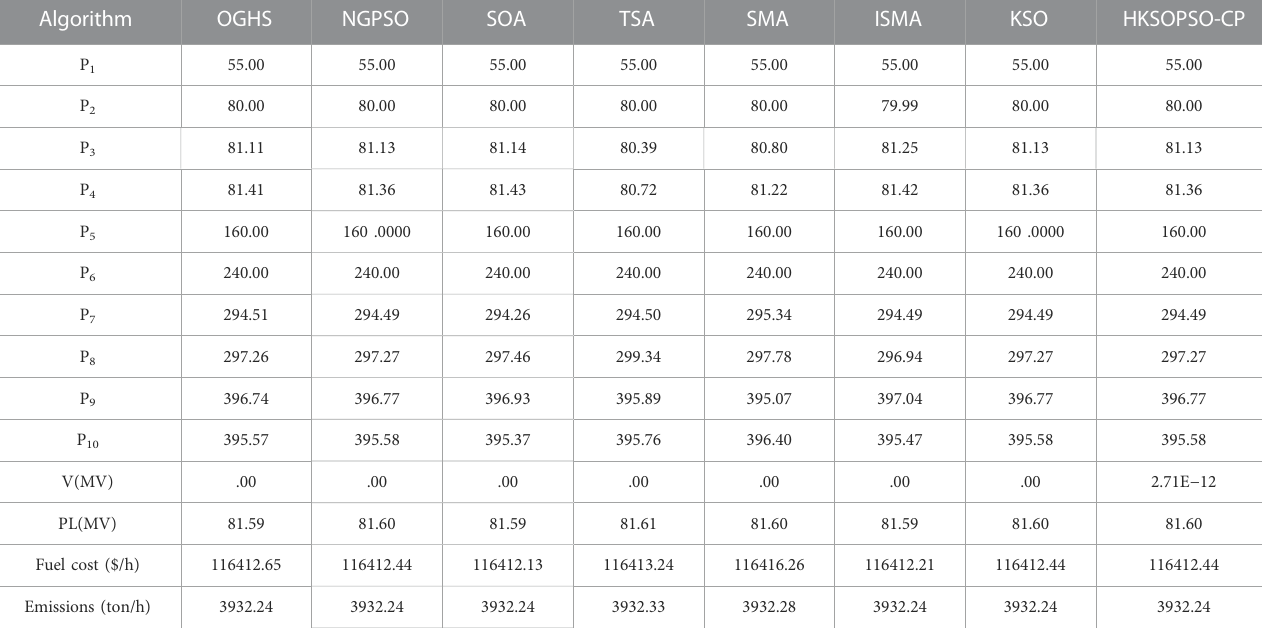
TABLE 9 Case 2 comparison between different algorithms optimizing for emission rate.